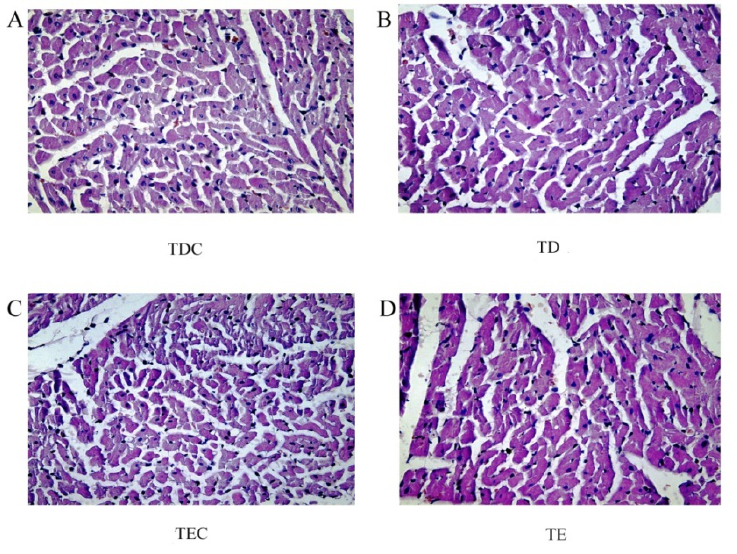
Figure 4. Left heart ventricle of sample rats from TDC, TD, TEC, and TE; n = 6 in each group. Hematoxylin-eosin